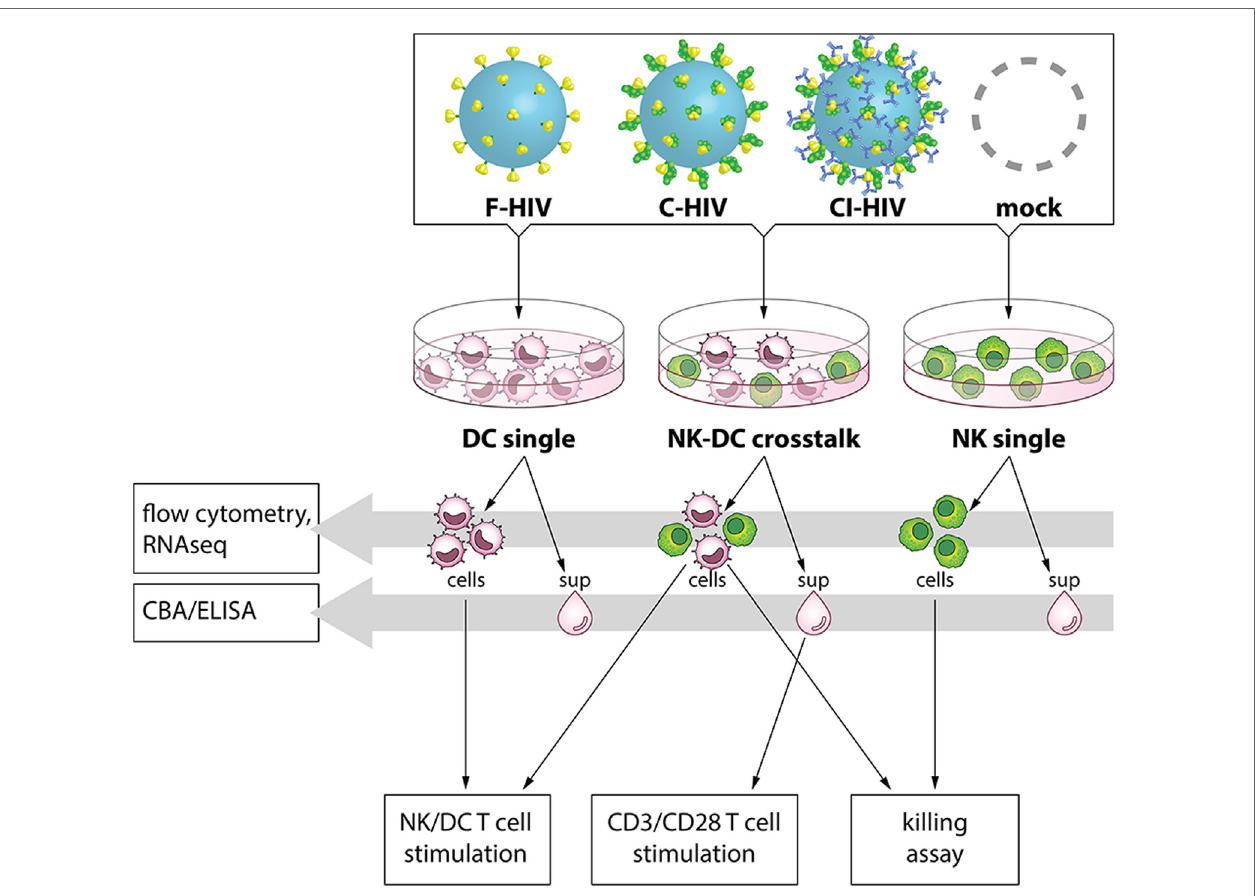
FigUre 1 | Experimental study design. Dendritic cells (DCs) and natural killer (NK) cells were kept in single cultures, or in cross talk cultures consisting of NK cells and DCs from the same donor at a 1:1 ratio and exposed to 1 μ g/ml F-HIV, complement-opsonized HIV (C-HIV), complement- and antibody opsonized HIV (CI-HIV), or mock treated for 24 h. Flow cytometry was performed to assess expression of activation markers on the cells, and the pathways activated were assessed by RNAseq. The concentration of cytokines in the supernatants was measured using a cytometric bead array (CBA) or ELISA. Allogeneic T cells were stimulated using cells from the cultures, or by CD3/CD28 ligation together with culture supernatants. The proliferation and the phenotype of the T cells was subsequently